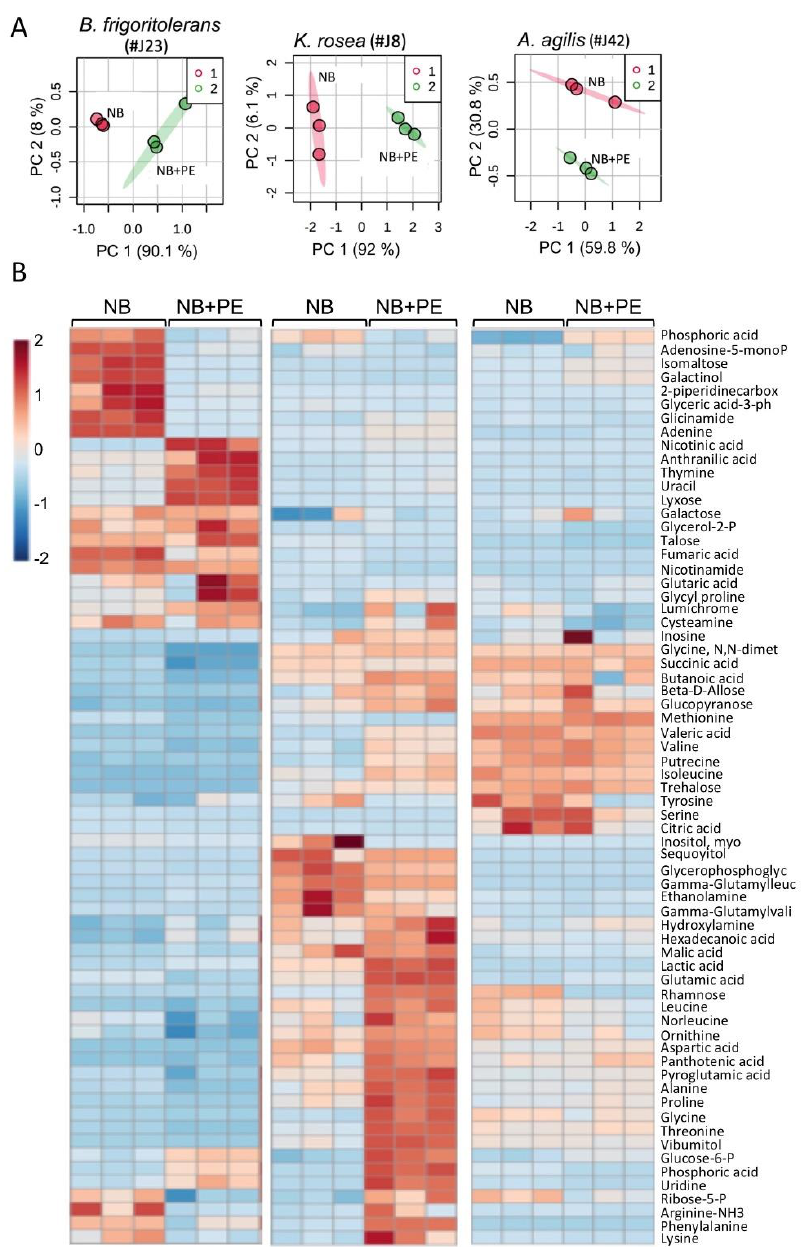
Figure 4. Analysis of primary metabolites synthesized by the isolated endophytes K. rosea , B. frig- oritolerans, and A. agilis ( A ) Score plots of principal component analysis (PCA) comparing bacterial metabolites grown in NB versus NB supplemented with PE (NB + PE). ( B ) A heatmap demonstrating differential synthesis of primary metabolites by the indicated endophytic bacteria cultured in NB or in NB + PE. The color key represents the fold change (log 2 ) of metabolites between NB and NB + PE samples.